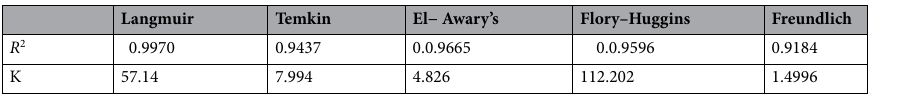
Table 5. R 2 Values for the various adsorption isotherms considered for APPH at 303 K.